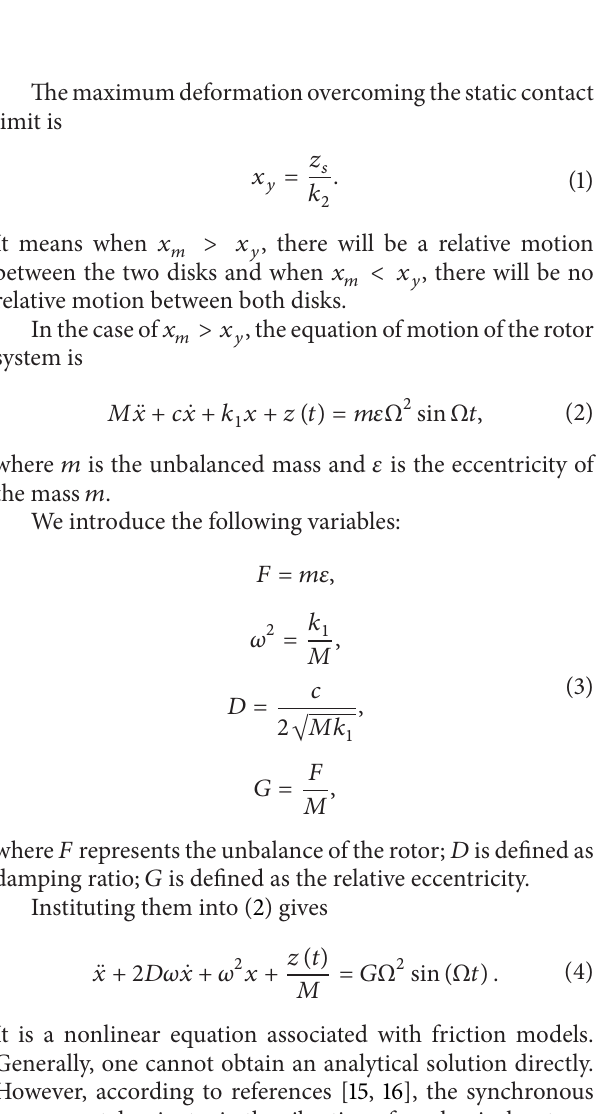
Figure 1: The basic operation principle of elastic support/dry friction damper (1: elastic support, 2: moving disk, 3: stationary disk, 4: rotor, and 5: rolling bearing, A: